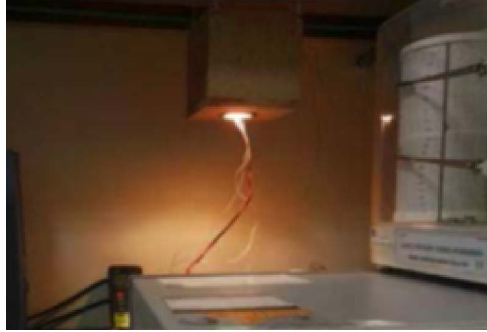
Figure 5. Photo of the experimental setup for the ALFHS or the CUFHS mounted to the CLRDL after INST.